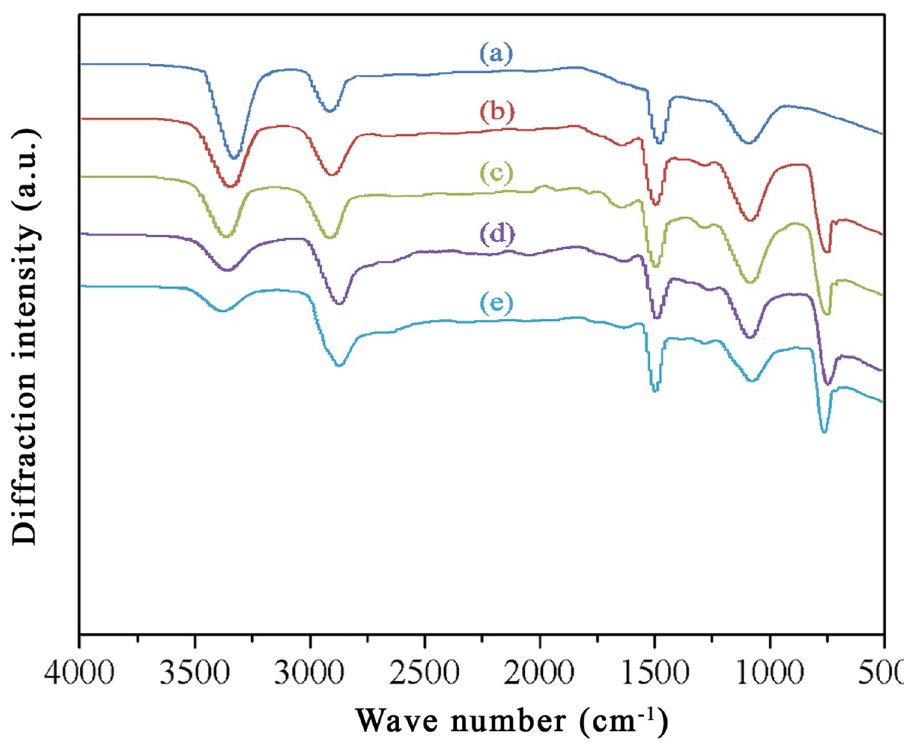
Fig 2. FTIR spectra of wood fibers treated by high-temperature impulse-cyclone drying and modified by A187. (a) 180˚C; (b) 180˚C+A187; (c) 200˚C+A187; (d) 220˚C+A187; (e) 240˚C+A187.